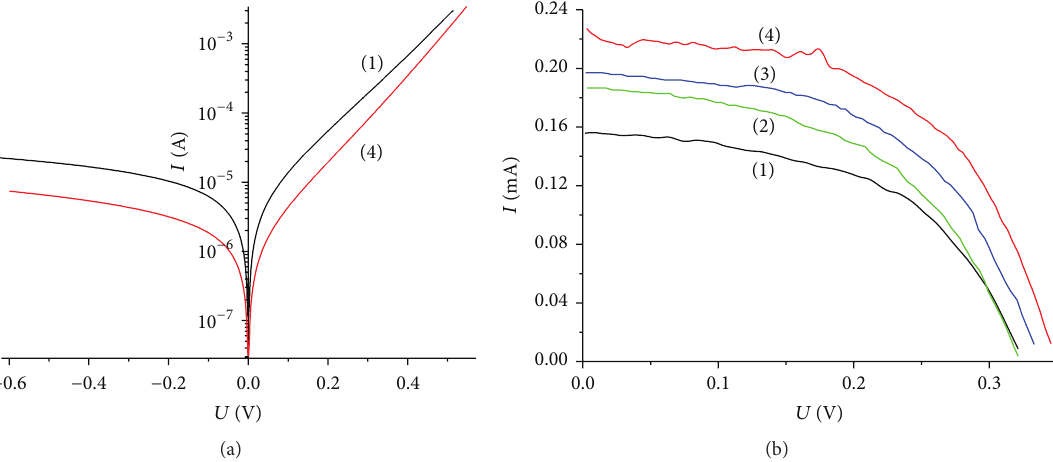
Figure 3: 𝐼 - 𝑈 characteristics of SJ Si-SC with VA p-n junction in the darkness (a) and under light illumination (b) for (1)—initial; (2)—after H + plasma etching for 5 min; (3)—(2) + Ar + + H + ; and (4)—(3) + DLC coating. The conditions of DLCF deposition are 𝑃 = 175 W, 𝑁 = 20%, and 𝑡 = 4 min. The conditions of illumination are 𝑃 = 100 mW/ c m 2 and 𝑆 = 0.03 cm 2